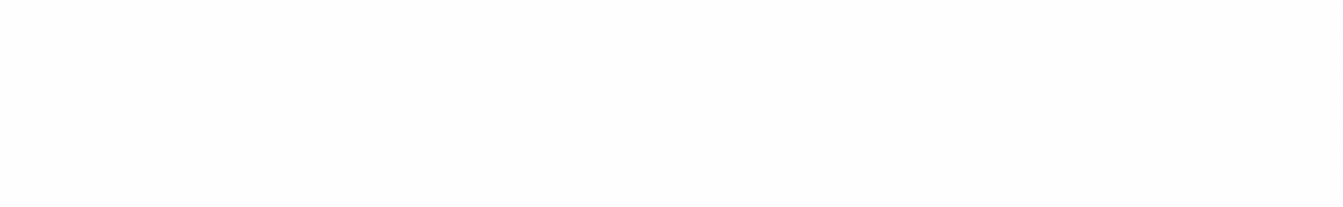
FIGURE 5 Dependence of the LCE spectrum of the Lorenz attractor on the values of x coordinate for r-28, or= 10, b=